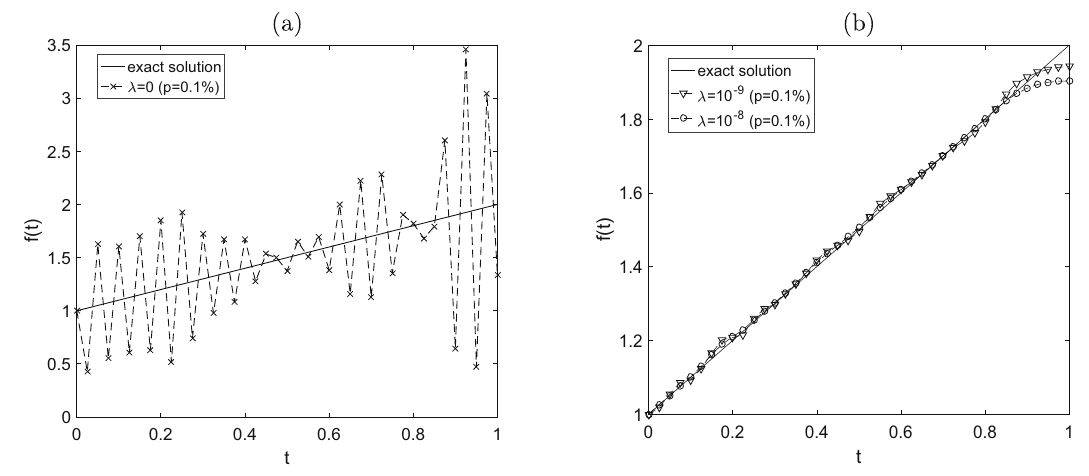
Figure 4: The exact ( 77 ) and approximate ( ) f t , for = p 0.1% with λ : ( a ) 0 and ( b ) 10 , 10 −9 −8 , for Example 1.